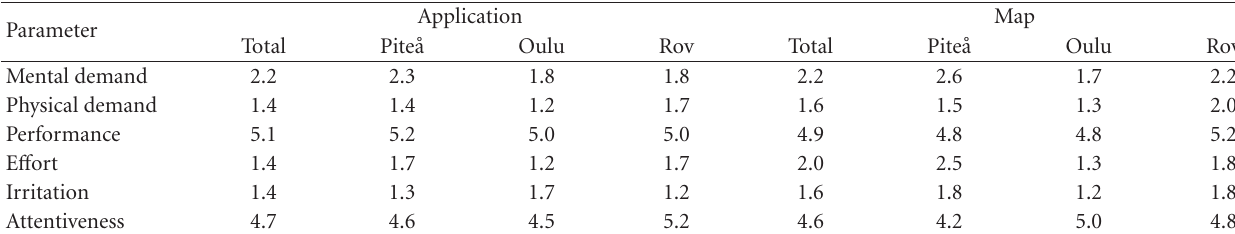
Table 2: NASA TLX results from study 1. Means from answers on scale